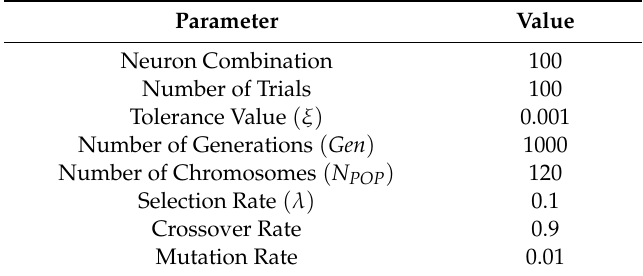
Table 2. List of parameters used in Hopfield Neural Network-Random 2 Satisfiability Genetic Algorithm (HNN-RAN2SATGA) [10].